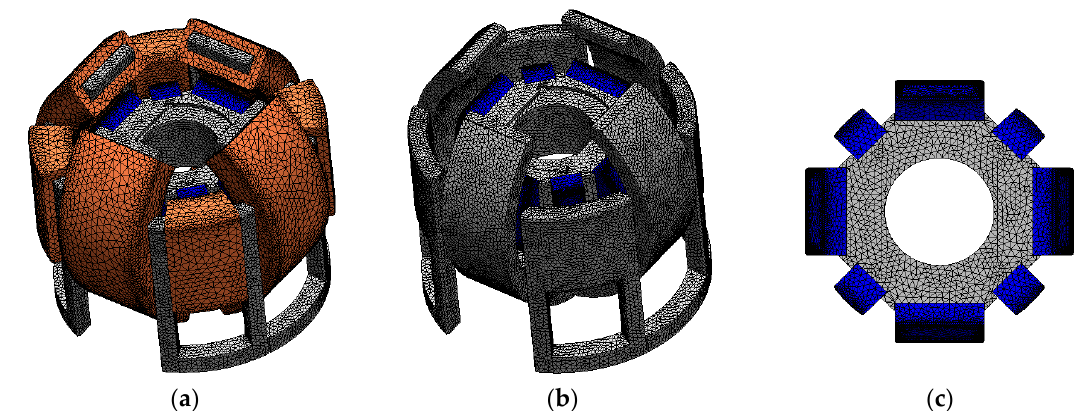
Figure 11. Three-dimensional (3-D) mesh model without the air region ( a ) Whole view; ( b ) Mover and stator without the coils; ( c ) Mover.